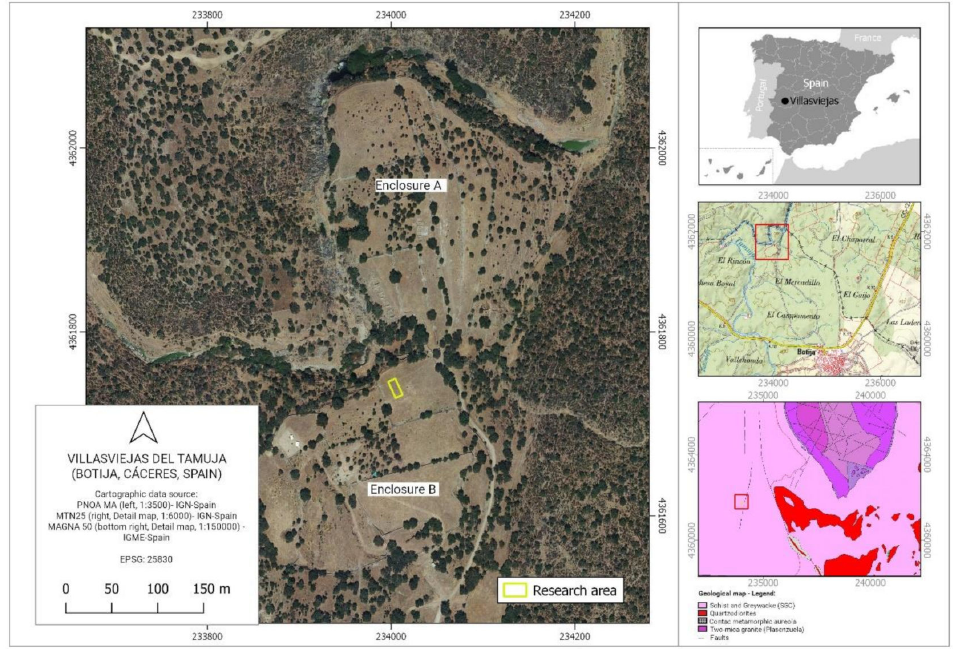
Figure 1. Location of the study area and geological map for the region. The yellow rectangle in enclosure B corresponds to the zone analysed in this work. The red rectangle in detailed maps corresponds to the area of the map on the